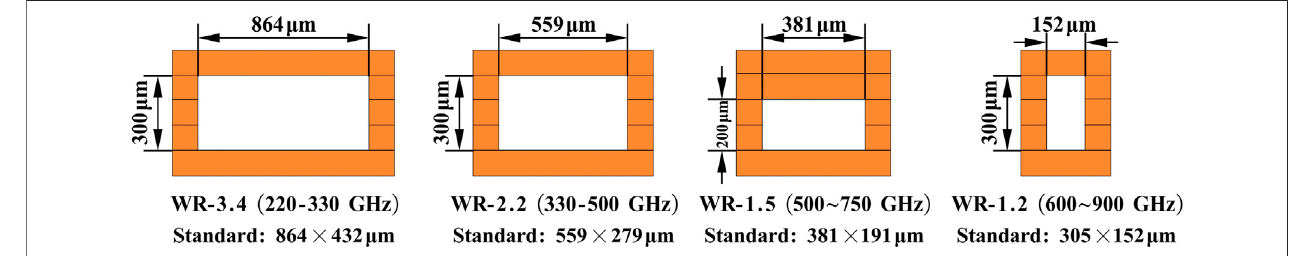
Frontiers in Physics |